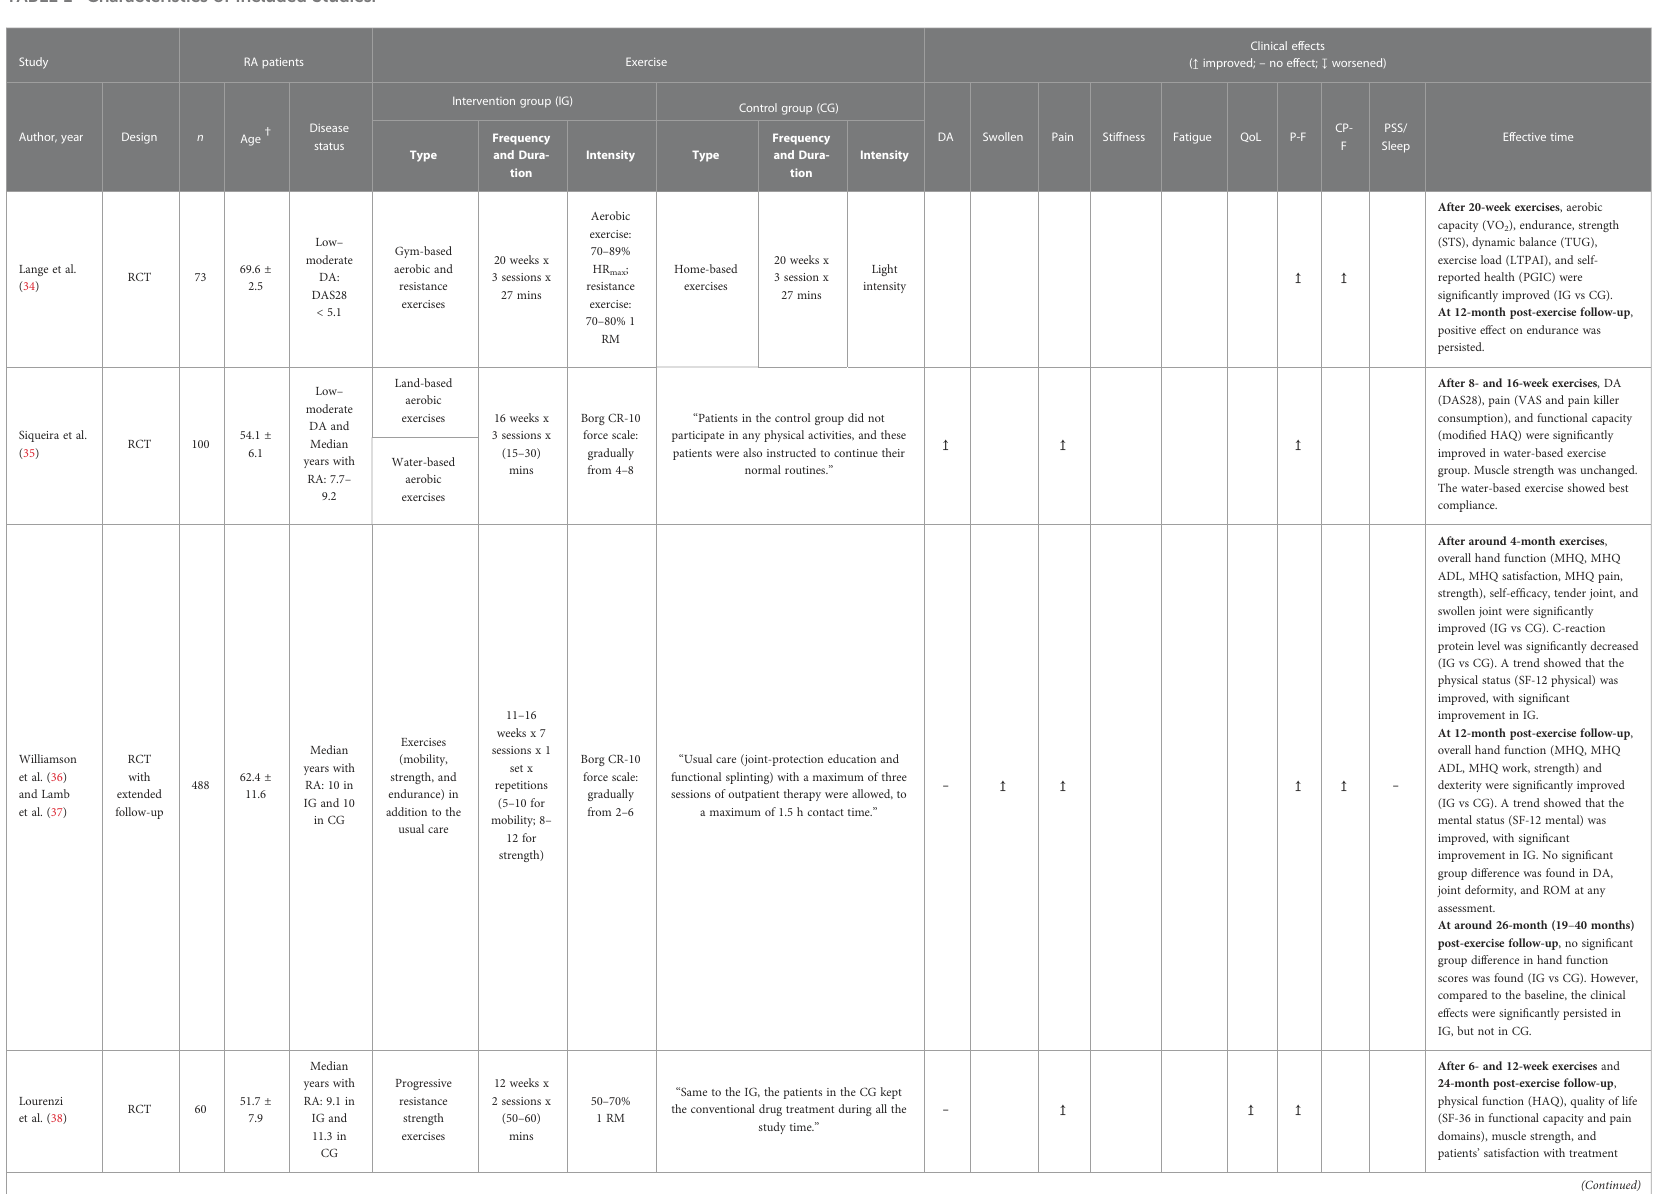
TABLE 1 Characteristics of Included